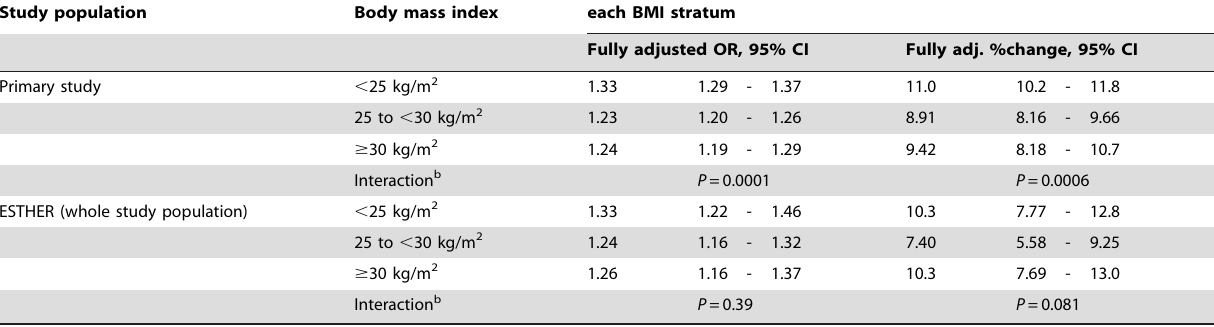
Table 7. Interaction analysis of alcohol with